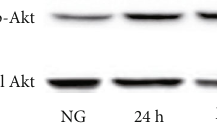
Figure 3: The e ff ect of HG and tangeretin activated the phosphorylation of Akt in RPE cells. RPE cells were stimulated with HG (30 mM) or 24.4mmol/l mannitol for 24 h. Cell lysates were immunoblotted with anti-p-Akt and anti-Akt antibodies. RPE cells were pretreated with 20 μ M tangeretin for 1h and then incubated with HG for 24h for the assay of Akt phosphorylation. Ta: tangeretin; Ma: mannitol.